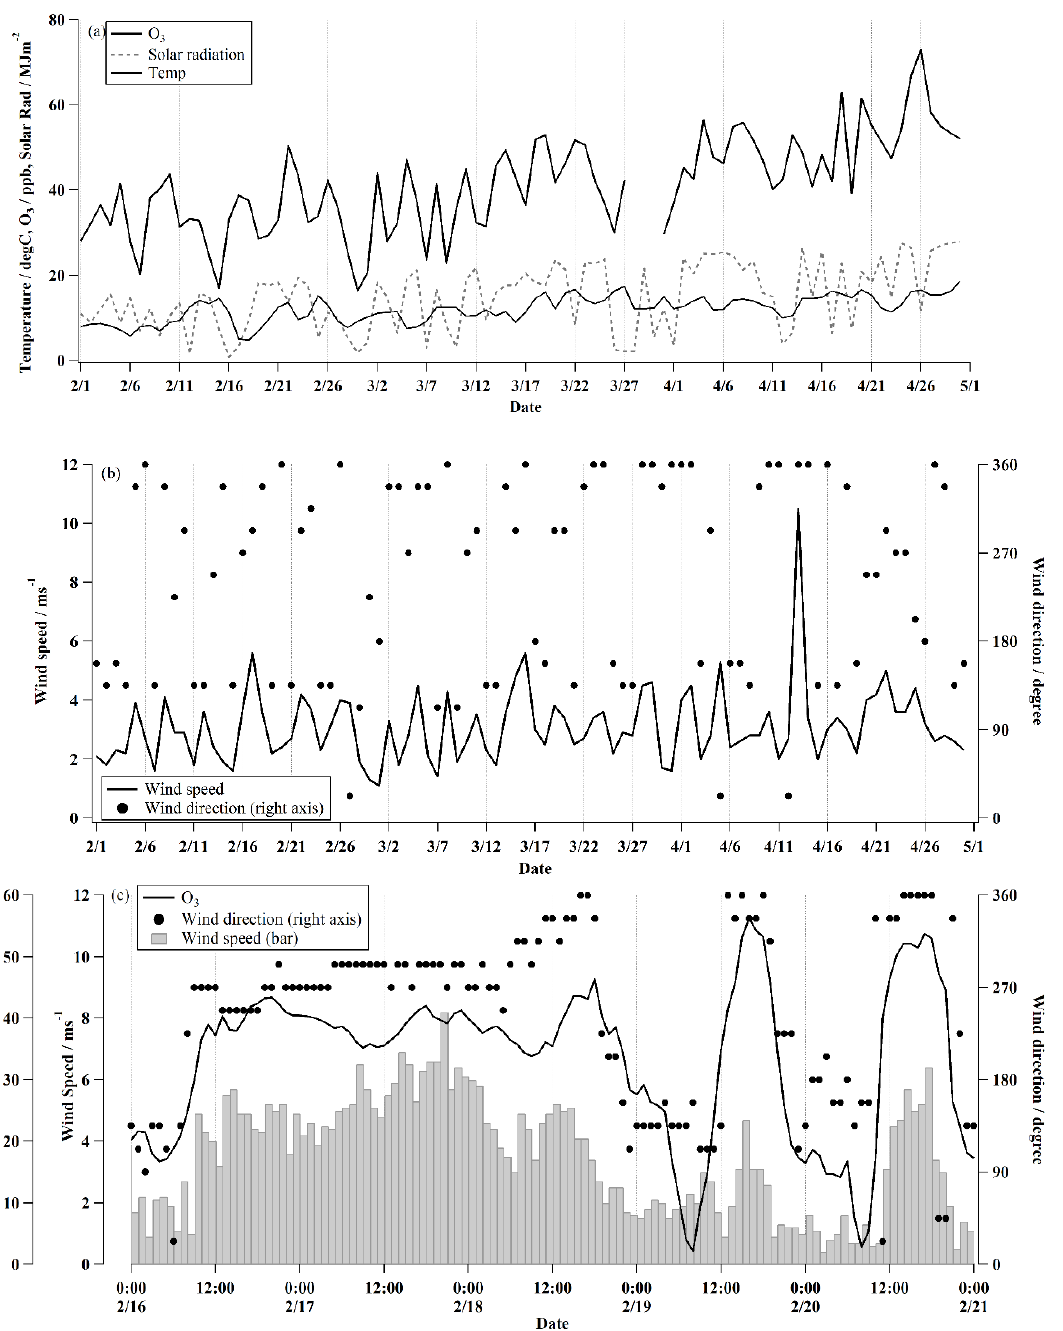
Figure 2. Time series of ozone, and meteorological data in spring 2020. ( a ) Ozone (O 3 ), temperature, and solar radiation. ( b ) Wind speed and wind direction. ( c ) Data from 16 to 21 February for ozone, wind speed, and wind direction.